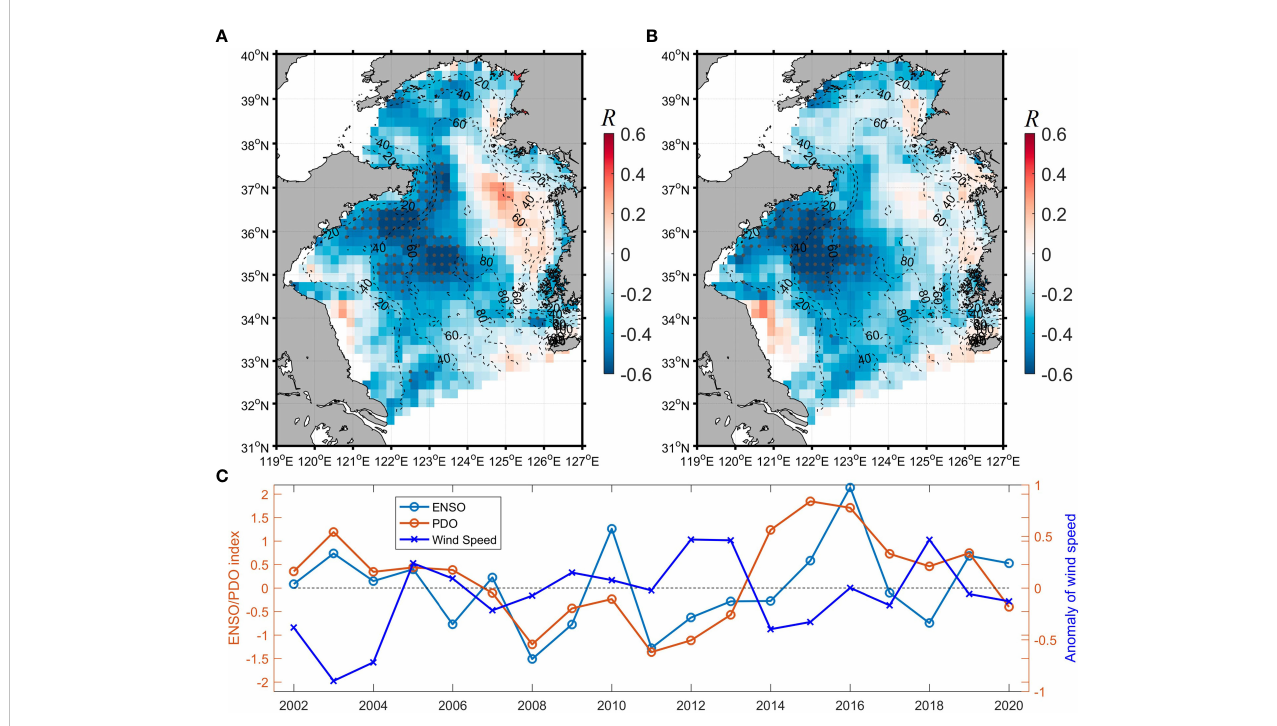
FIGURE 4 The correlation coef fi cient R for the interannual PDO-Chl-a (A) and ENSO-Chl-a (B) correlation analyses, respectively. The gray dots in (A, B) denote the location of signi fi cant correlation ( P <0.05). (C) The interannual variability of the summer mean wind speed (m/s) over the Yellow Sea and the ENSO/PDO indexes from 2002 to